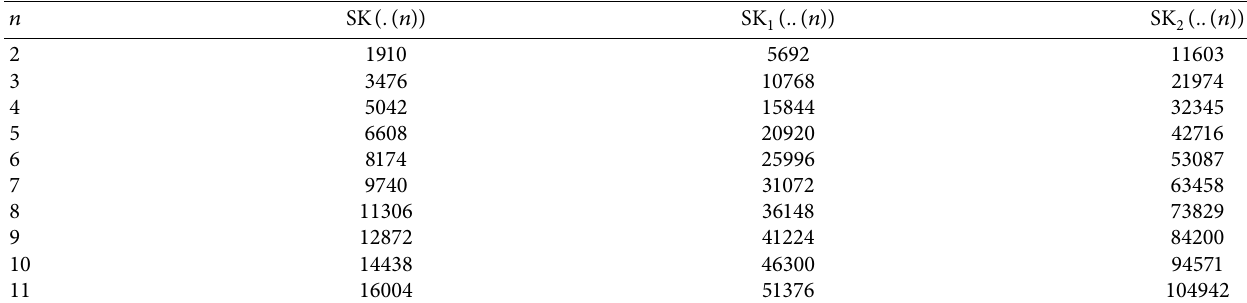
Table 4: Comparison of SK and its